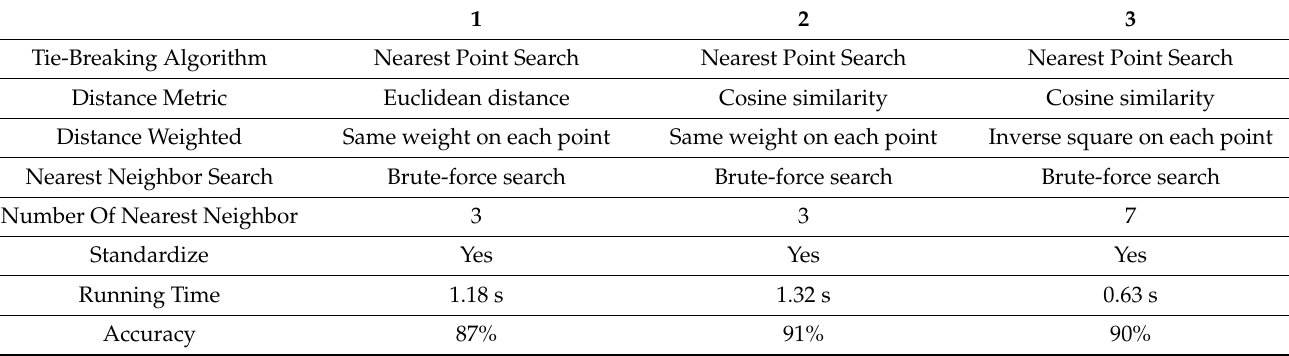
Table 3. Comparison of parameters of models trained using the time-domain feature when the propeller is damaged. 1 2